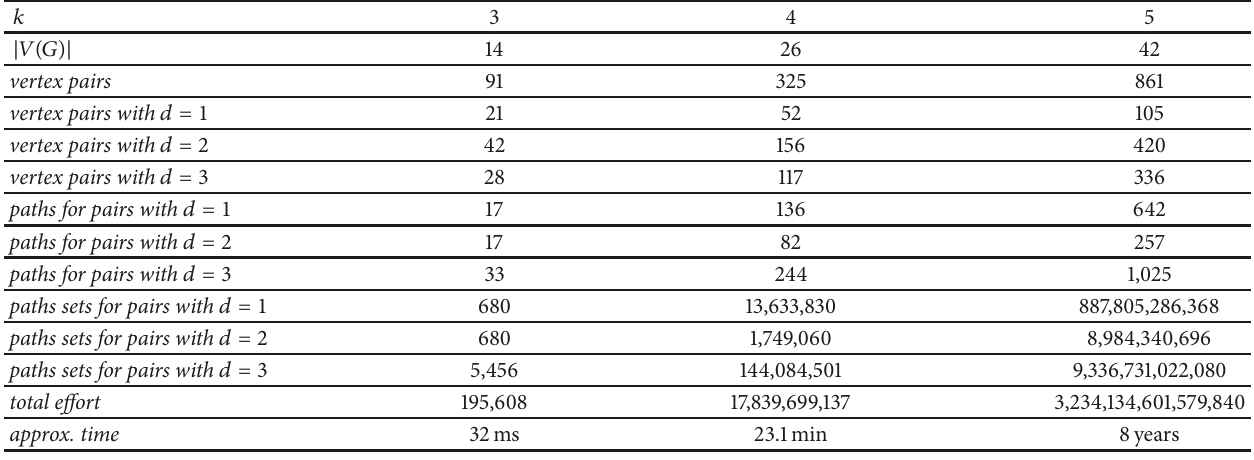
Table 2: Growth with 𝑘 of the effort to find the sets of disjoint paths sets.